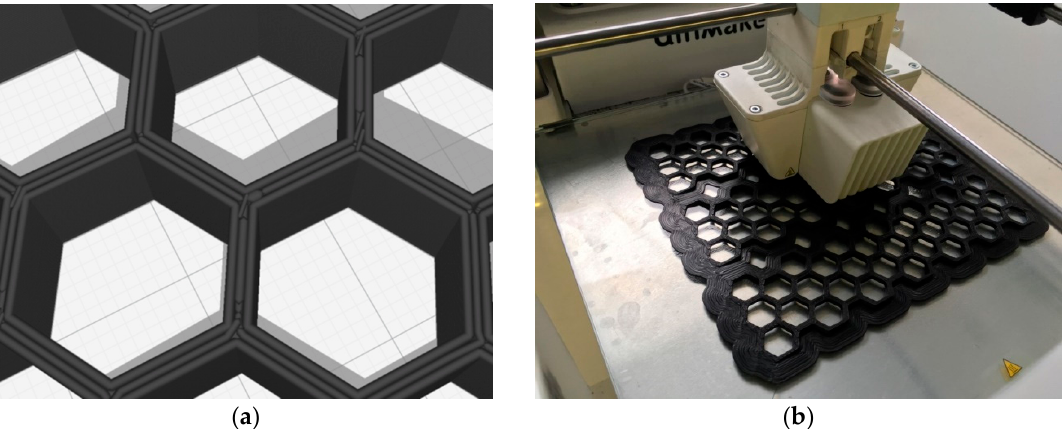
Figure 1. ( a ) The three-layered structure of printed hexagon walls. ( b ) A set of three spatial reinforcing elements being 3D printed (photos by T. Szatkiewicz).